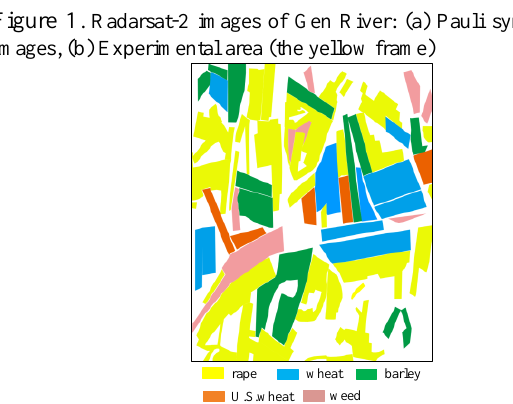
Figure 2. The first team of Shangkuli farm species type